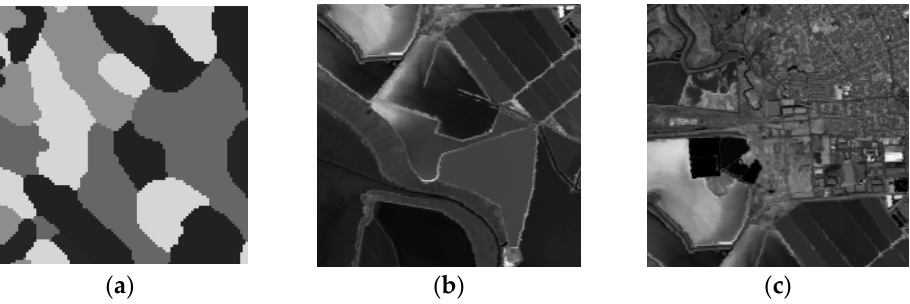
Figure 5. Synthetic and real HS images utilized in the experiment. ( a ) The 50th band of the synthetic HS image with camouflage pattern; ( b ) the 50th band of the real HS image with simple textures; ( c ) the 50th band of the real HS image with complex textures.